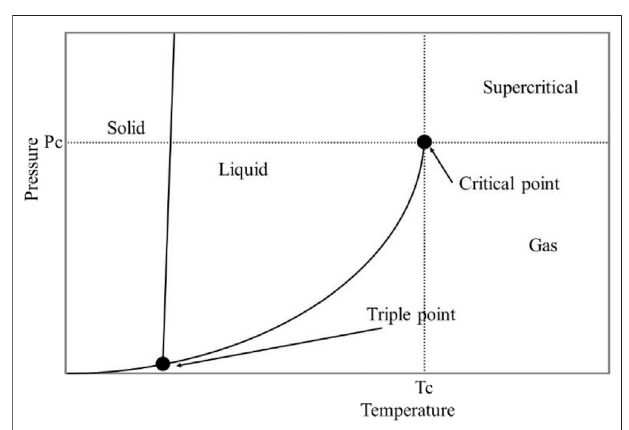
FIGURE 7 | Pressure – temperature phase diagram of a compressible fl uid with solid – liquid – gas phase and supercritical region. P T c : critical temperature. Reproduced with permission from Li et al.